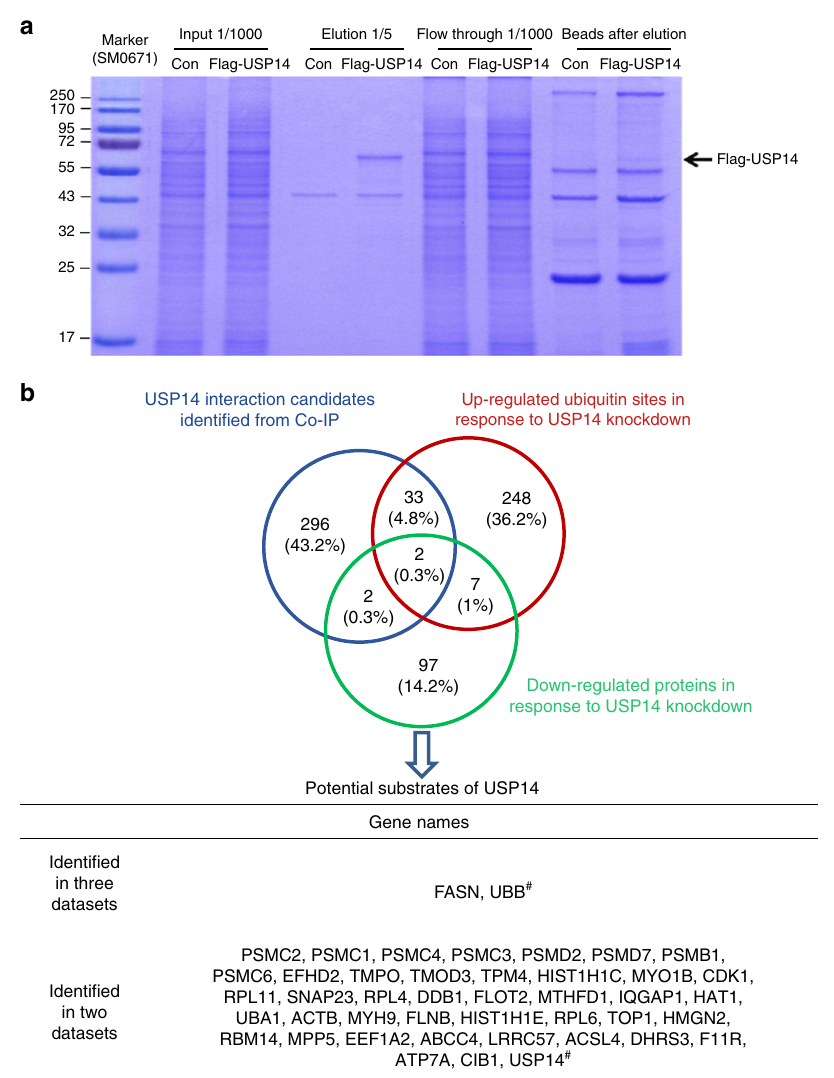
Fig. 4 Puri fi cation of USP14 interacting proteins and identi fi cation of potential USP14 substrates. a The immunoprecipitation of Flag-USP14 interacting protein was visualized by Coomassie blue staining. b Venn diagram showing the number of downregulated proteins identi fi ed in response to USP14 KD (green), USP14 interaction candidates identi fi ed in Co-IP process (blue), upregulated ubiquitin sites identi fi ed in response to USP14 KD (red) and overlapping proteins in the datasets. The chart below shows potential substrates of the overlapped